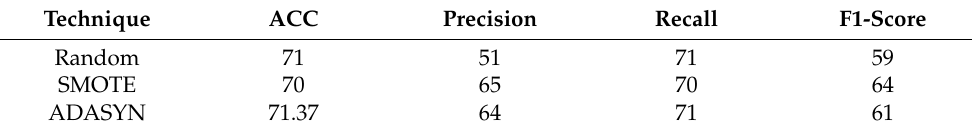
Table 8. Evaluation metrics for the Morris power dataset with oversampling.